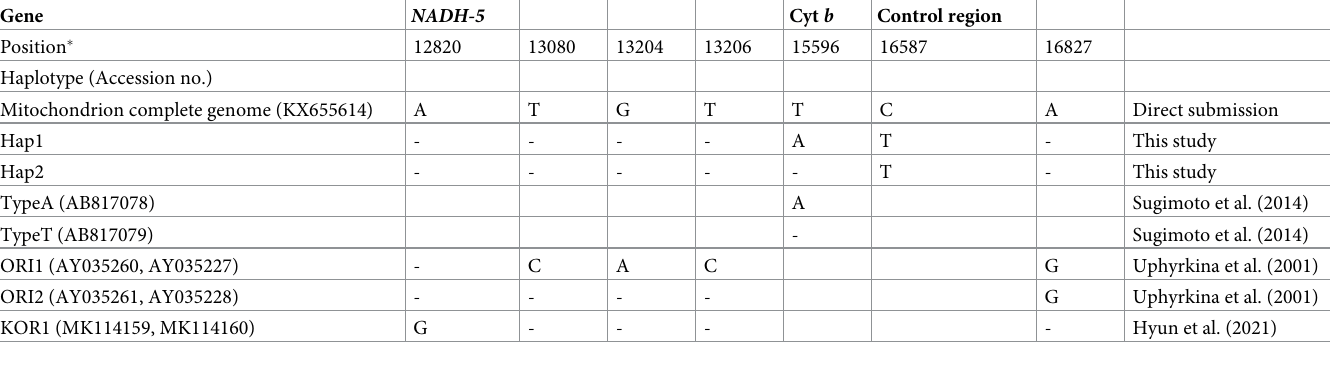
Table 3. Mitochondrial DNA sequence variations in Amur leopard.